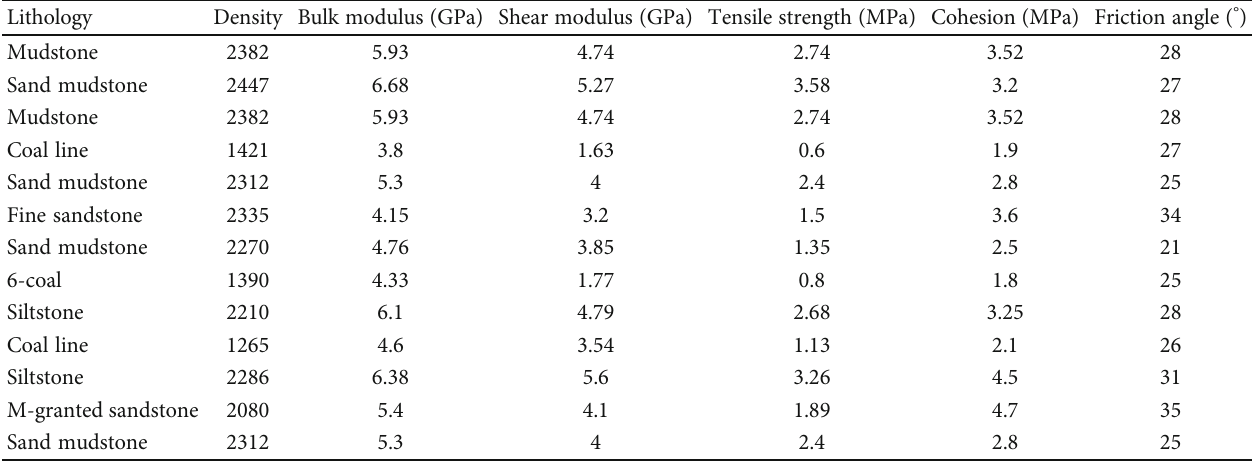
Table 2: Physical and mechanical parameters of rock.